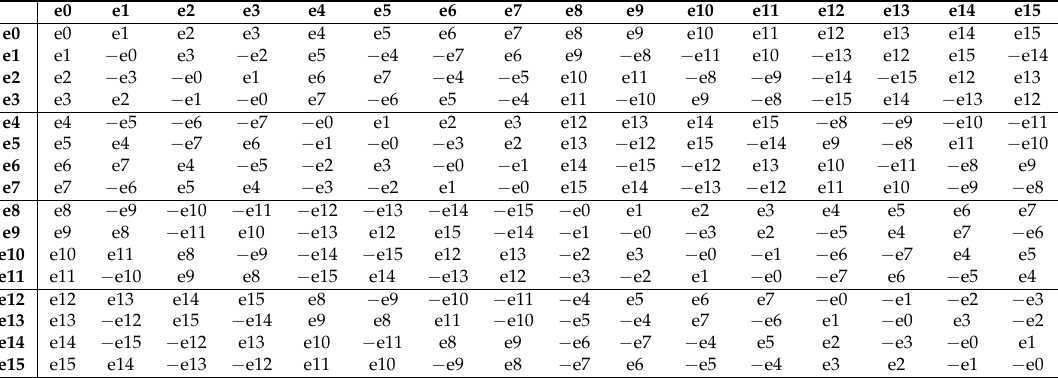
Table 2. The multiplication table of sedenion. For convenience, ‘ e N ’s are represented as ‘eN’ ; e.g., e 3 →